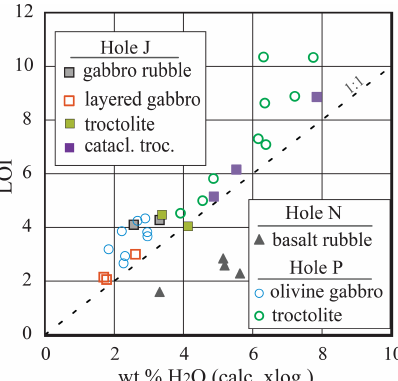
Figure 13. A comparison of the measured weight loss on ignition (LOI) with the wt% H 2 O calculated from the sum of the wt% of each hydrated mineral calculated using the Rietveld refinement (this study). The diagram shows that LOI values slightly exceed the cal- culated H 2 O contents (see